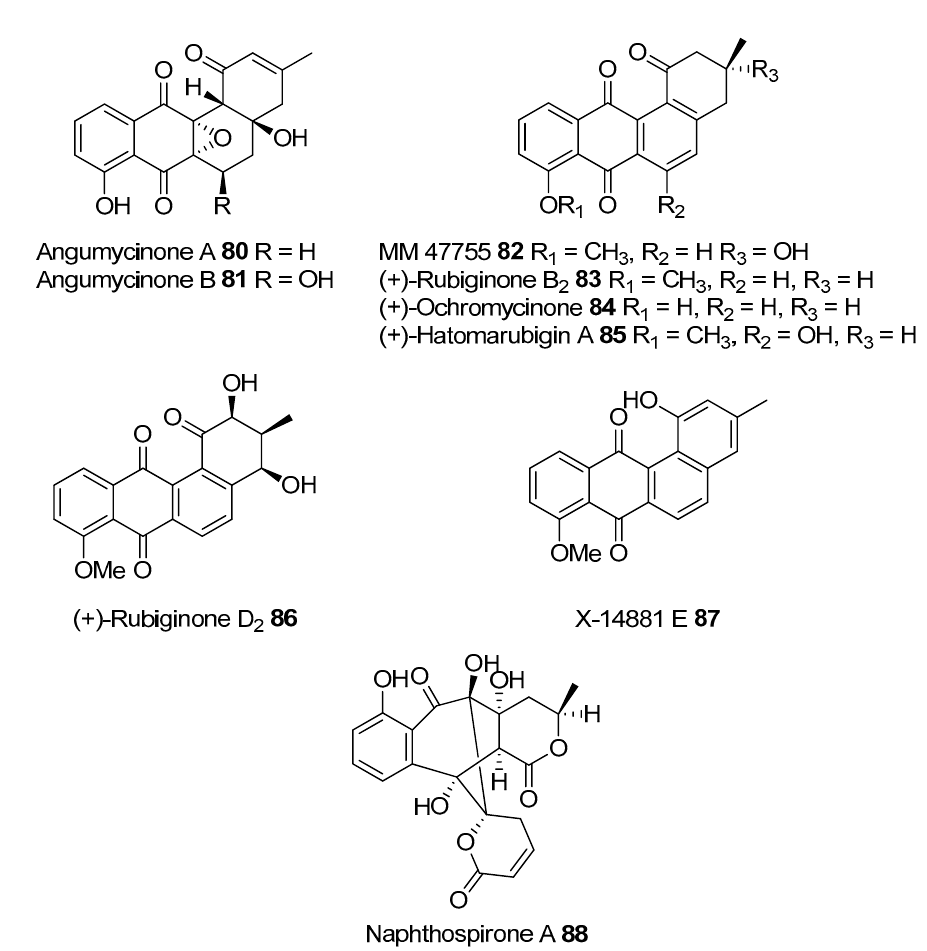
Figure 21. Polyketides discovered from cultured Actinomycete strains isolated from highly acidic mine drainage and highly basic mine tailings.